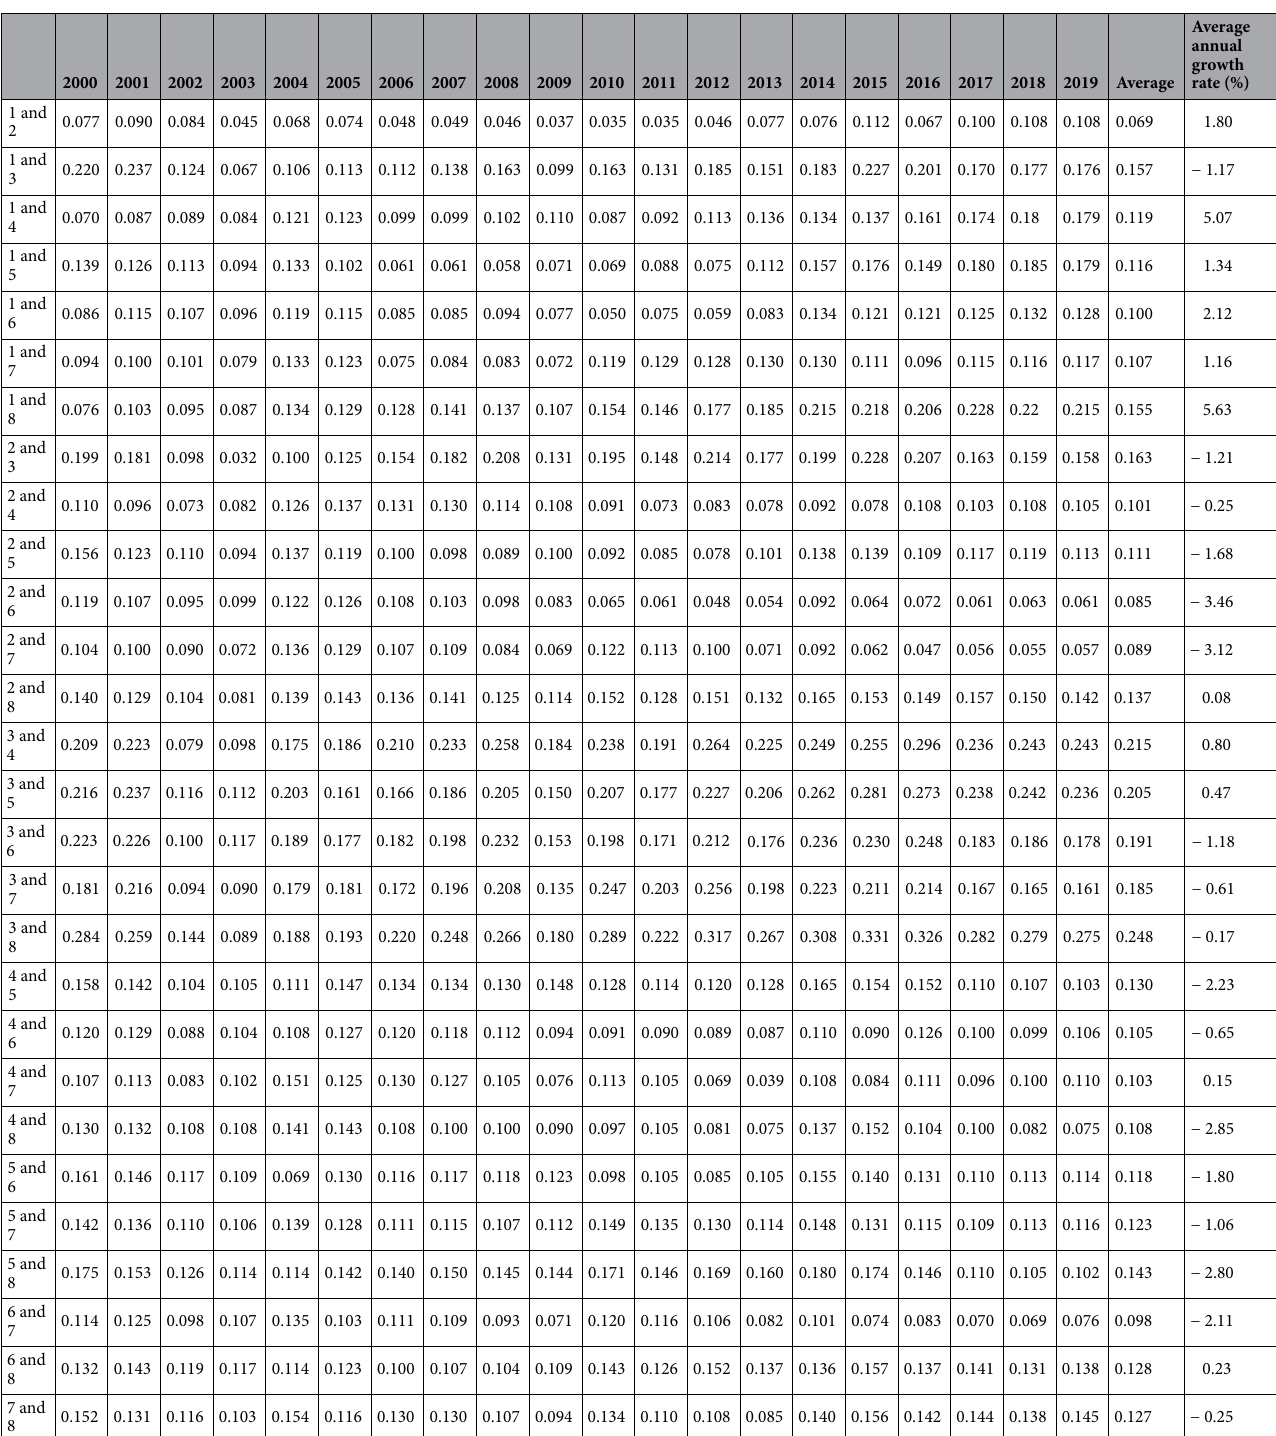
Table 5. The difference of CEEIE between regions. 1 is northern coast region; 2 is eastern coast region; 3 is southern coast region; 4 is northeast region; 5 is middle Yellow River region; 6 is middle Yangtze River region; 7 is southwest region; 8 is northwest